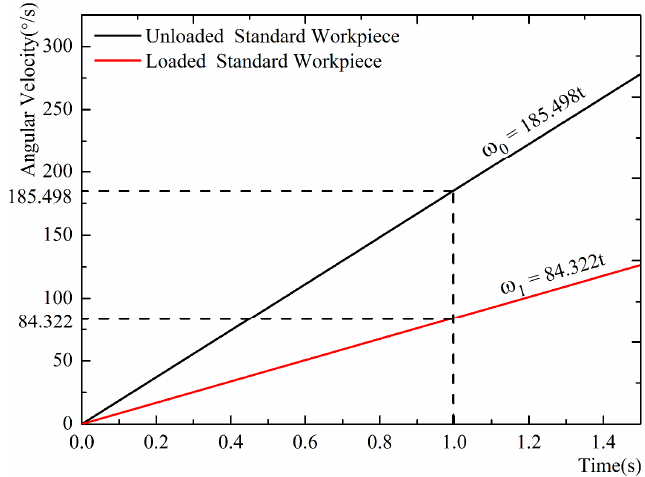
Figure 6. The relationship between the angular velocity and time of standard workpiece in different states. Table 9. Inertia simulation data in adams.